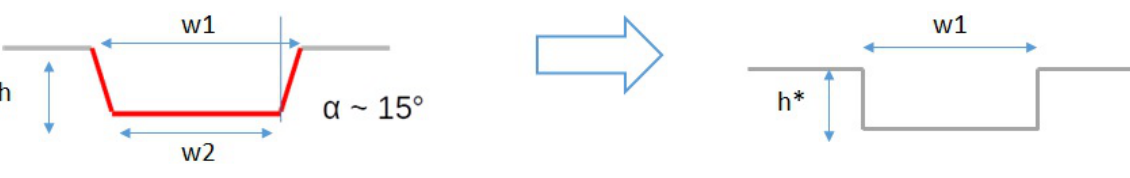
Figure 8. Realistic channel cross section and equivalent model cross section with identical hydraulic diameter. h and h*–channel depth; w1–channel top width; w2–channel bottom